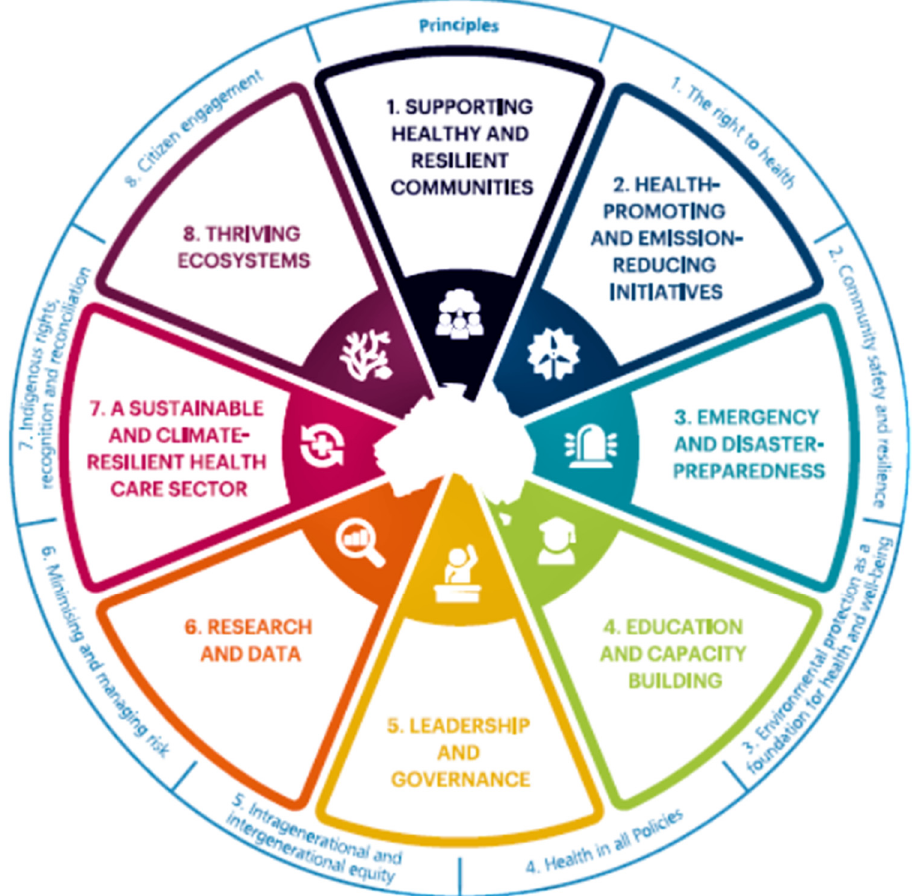
Figure 4. Key areas of health policy action. From: Healthy, Regenerative and Just, Framework for a National Strategy on Climate, Health and Well-being for Australia. Climate and Health Alliance (CAHA) 2021.